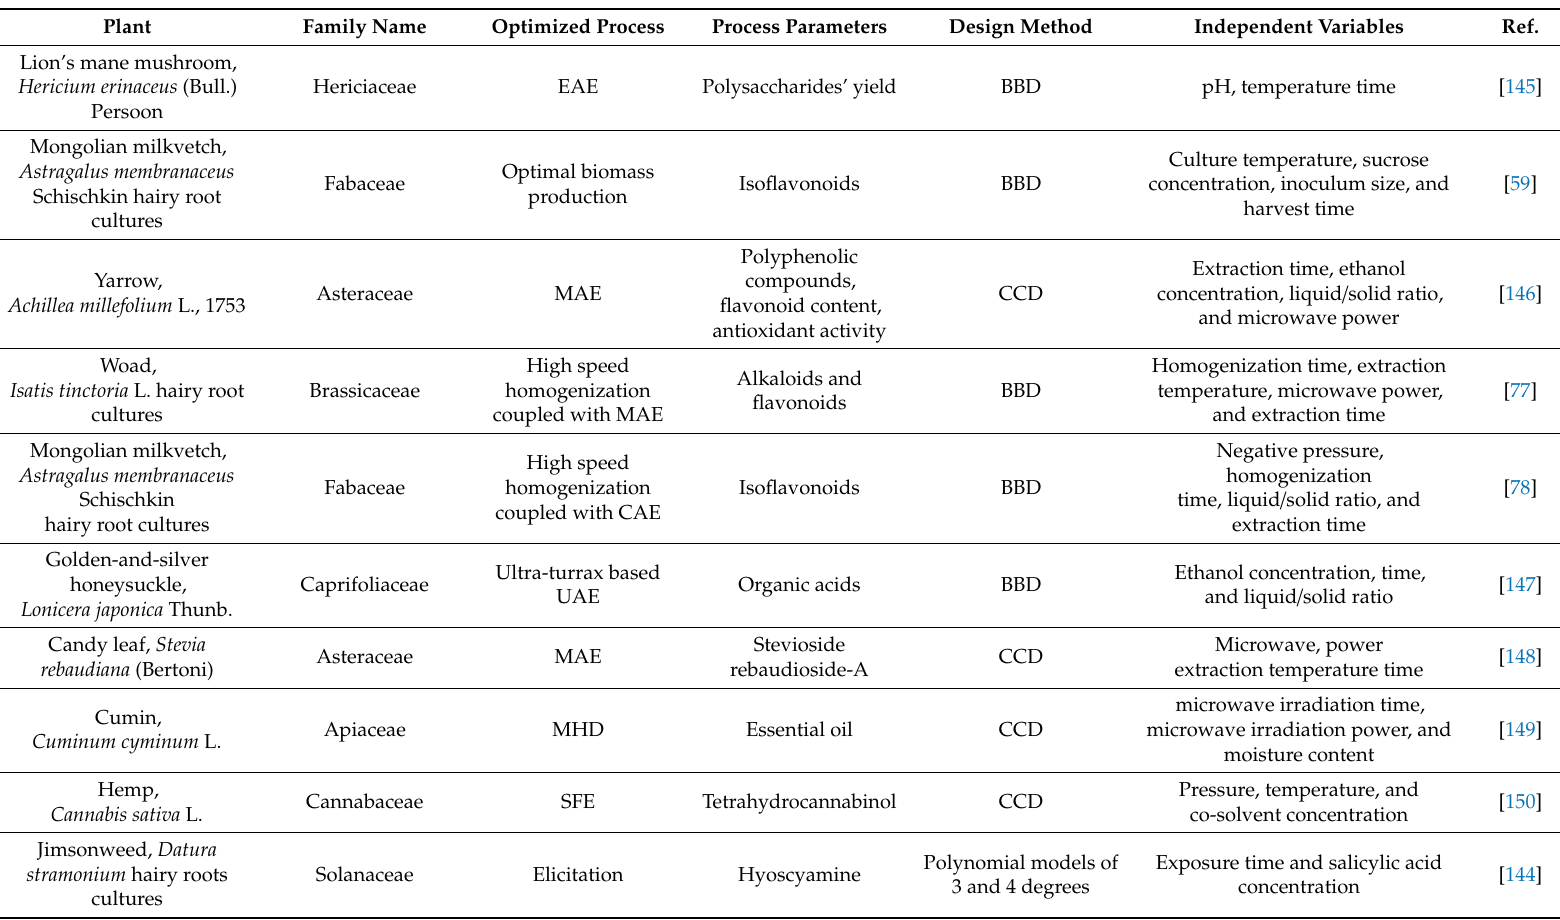
Table 6. Optimization studies using the response surface method for the production of biologically active compounds from plant